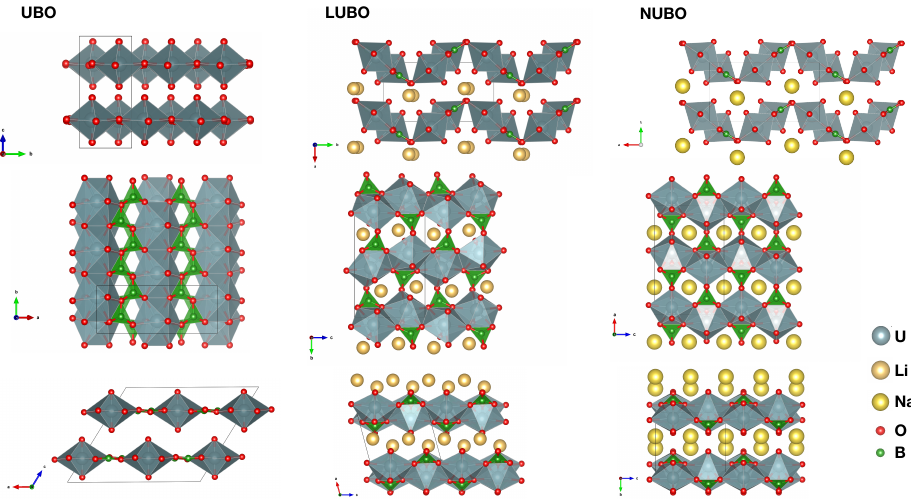
Figure 2. Views of the crystal structures of UBO , LUBO and NUBO